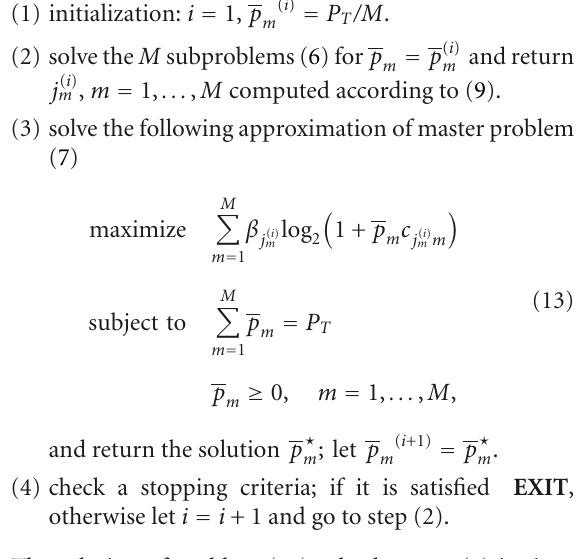
Algorithm 1. Approximated primal decomposition